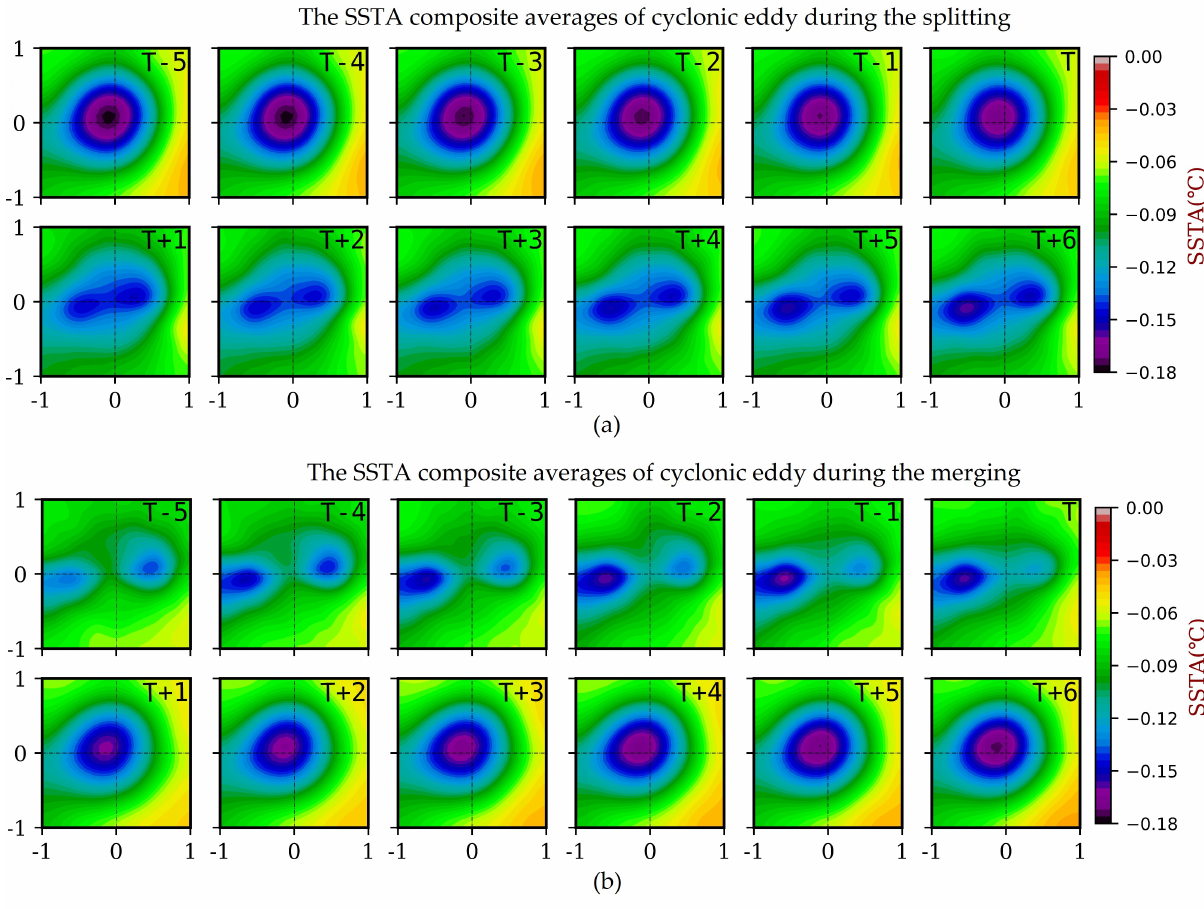
Figure 16. The SSTA composite averages of cyclonic eddy during the splitting and merging over the 24-year period (January 1996–December 2019), where ( a , b ) present eddy splitting process and eddy merging process, respectively. The top panel and the bottom panel represent the source branch and sink branch of the event, respectively, for both Figure 16a,b. Moreover, T is the day of splitting or